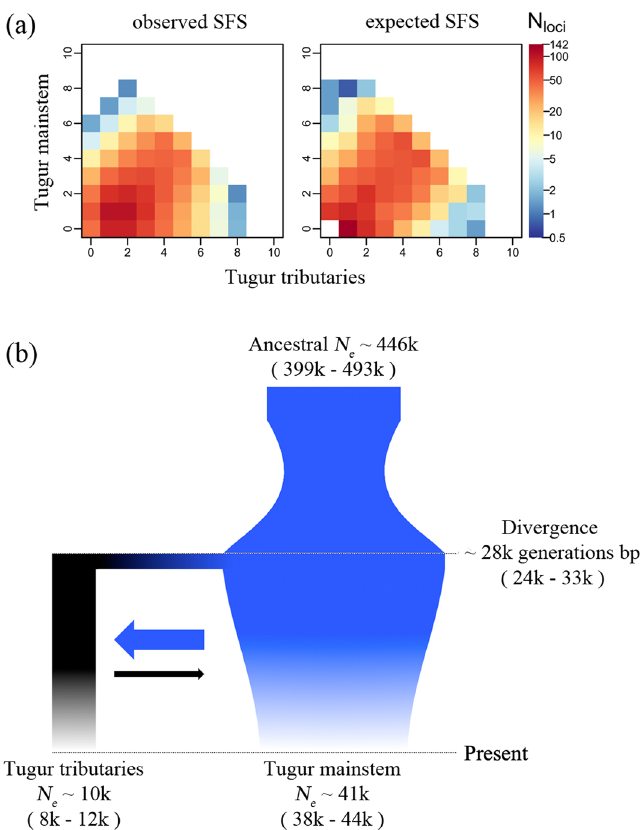
Figure 5. The expected versus observed SFS for the best fit model shows substantial overlap ( a ). Panel ( b ) shows the schematic representing the best fit model (model 1) from demographic inference using fastsimcoal2 . Coalescent Ne is given for population, with branch and arrow width corresponding to population size and level of gene flow, respectively (but not drawn to scale). Numbers in parentheses represent 95% confidence